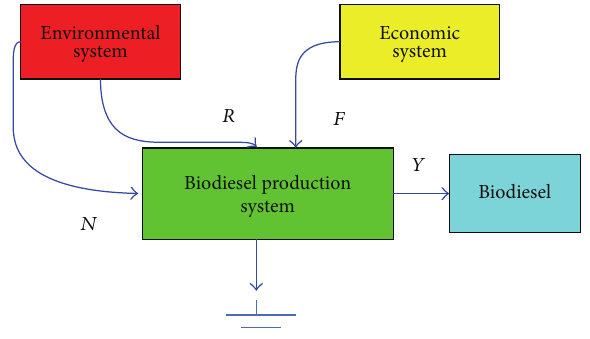
Figure 1: Inputs and outputs emergy flows of the biodiesel produc- tion